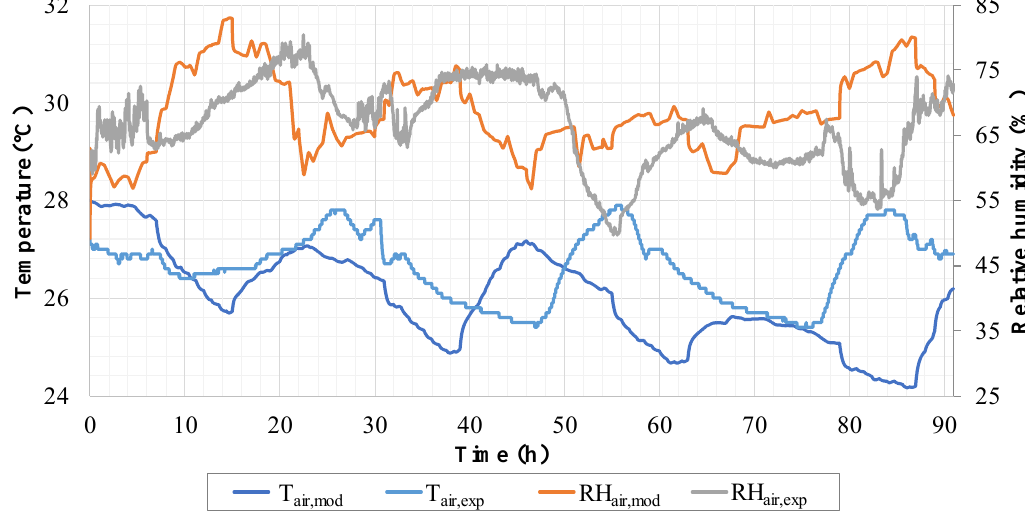
Figure 8. Measured and simulated air temperature and relative humidity.